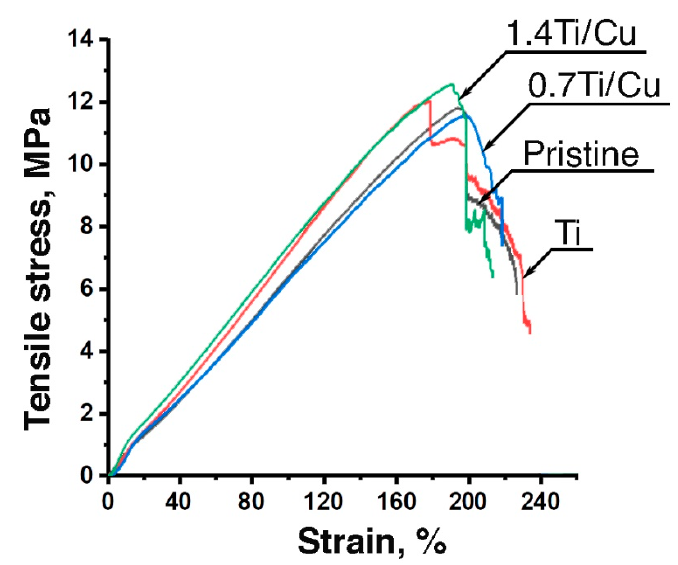
Figure 4. Stress-strain curves of plasma modified VDF-TeFE scaffolds. Figure 4 . Stress-strain curves of plasma modified VDF-TeFE scaffolds . The stress-strain curves are almost straight until the maximum tensile stresses are Table 4. Mechanical properties of plasma modified VDF-TeFE scaffolds. reached. Table 4. Mechanical properties of plasma modified VDF-TeFE scaffolds.